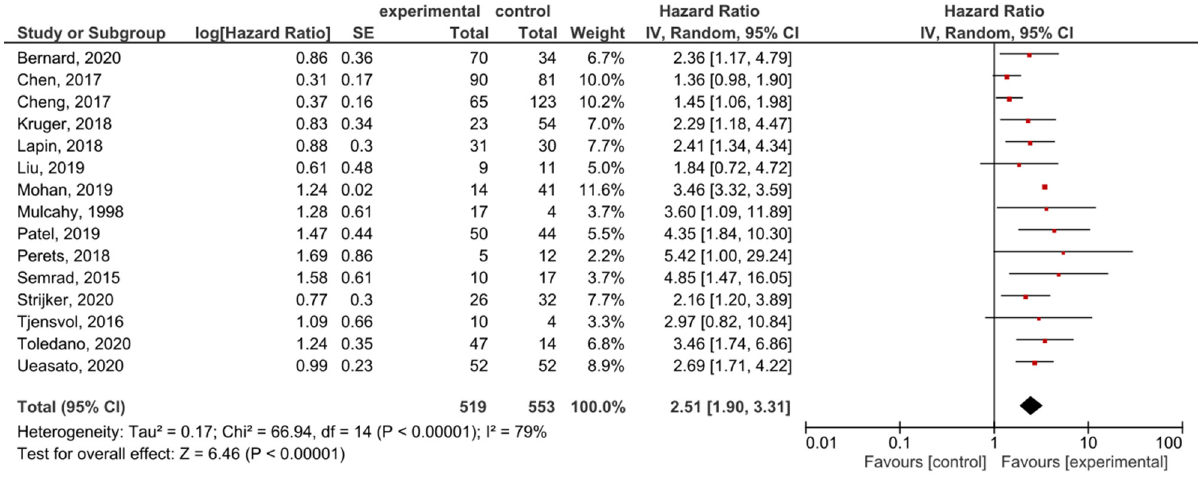
Figure 7. Forest plot presenting the relationship between the presence of KRAS mutations before treatment in locally- advanced and metastatic PDAC patients and OS.